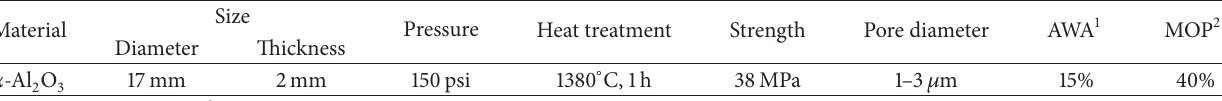
Table 2: The optimized preparation conditions and the properties of alumina substrates.